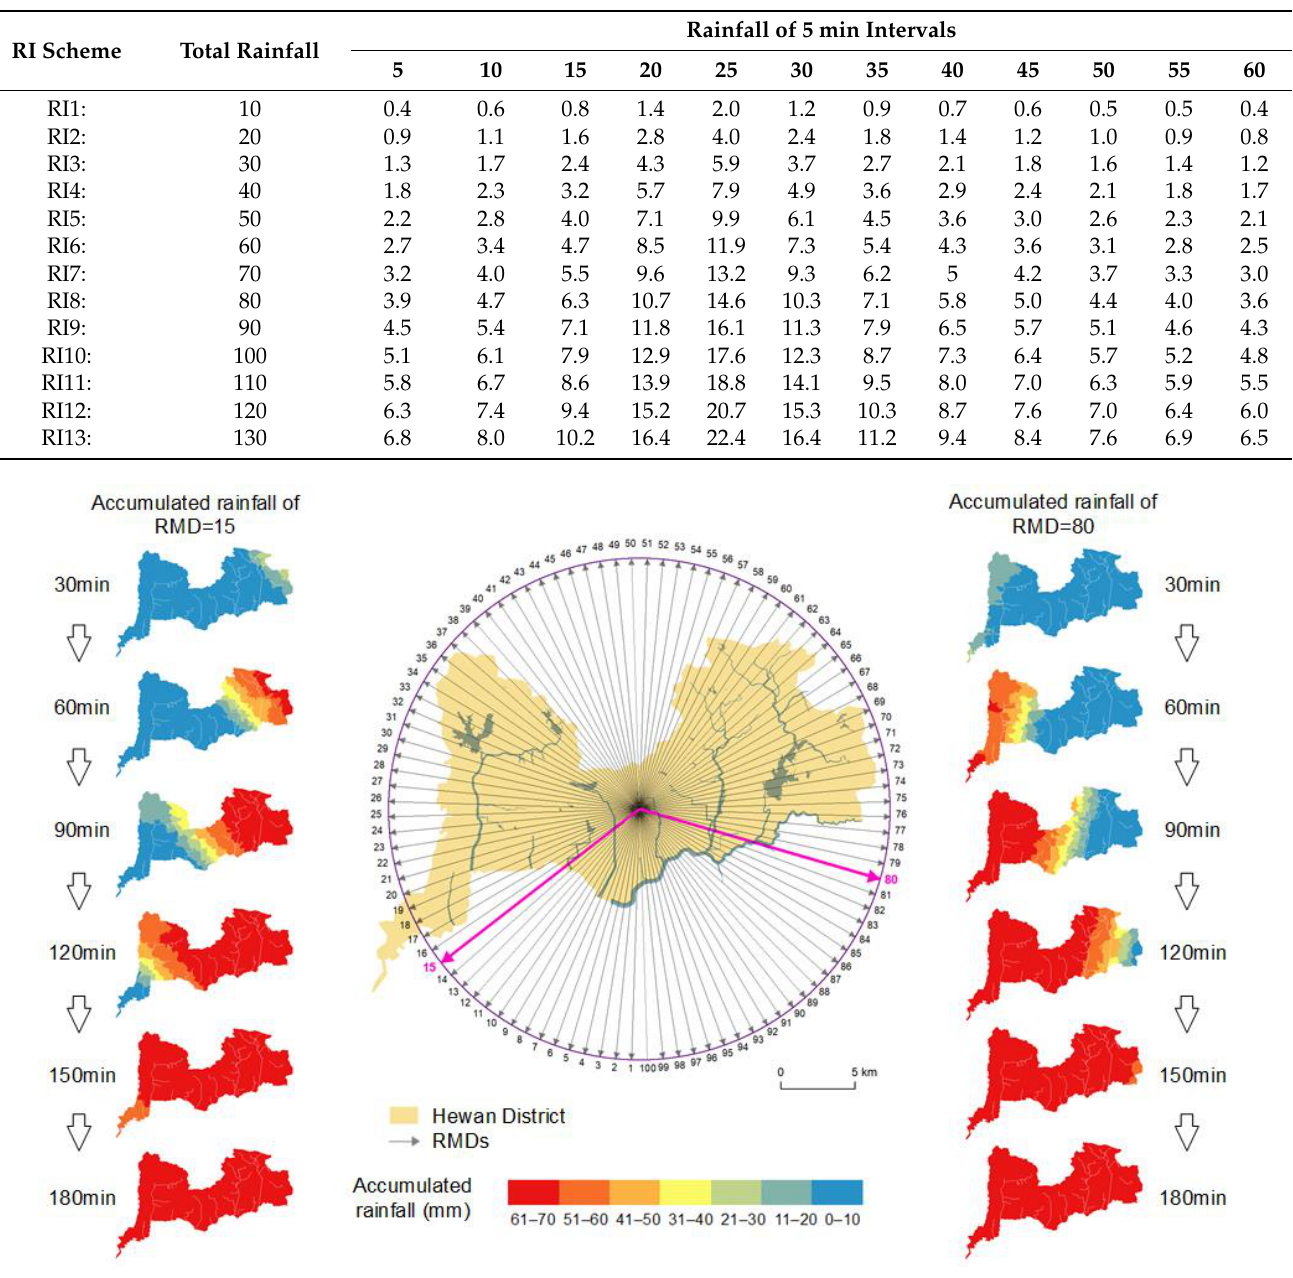
Figure 1. Schematic diagram of rainfall schemes.